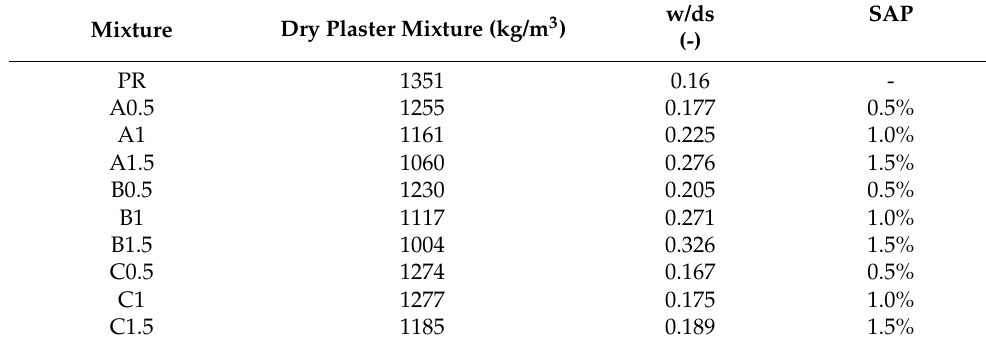
Table 2. Composition of studied